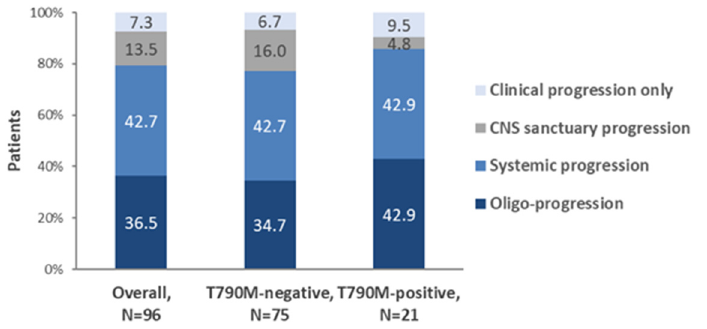
Figure 4. Patterns of disease progression in the first-line treatment setting among the overall popu- lation and the T790M-positive and negative